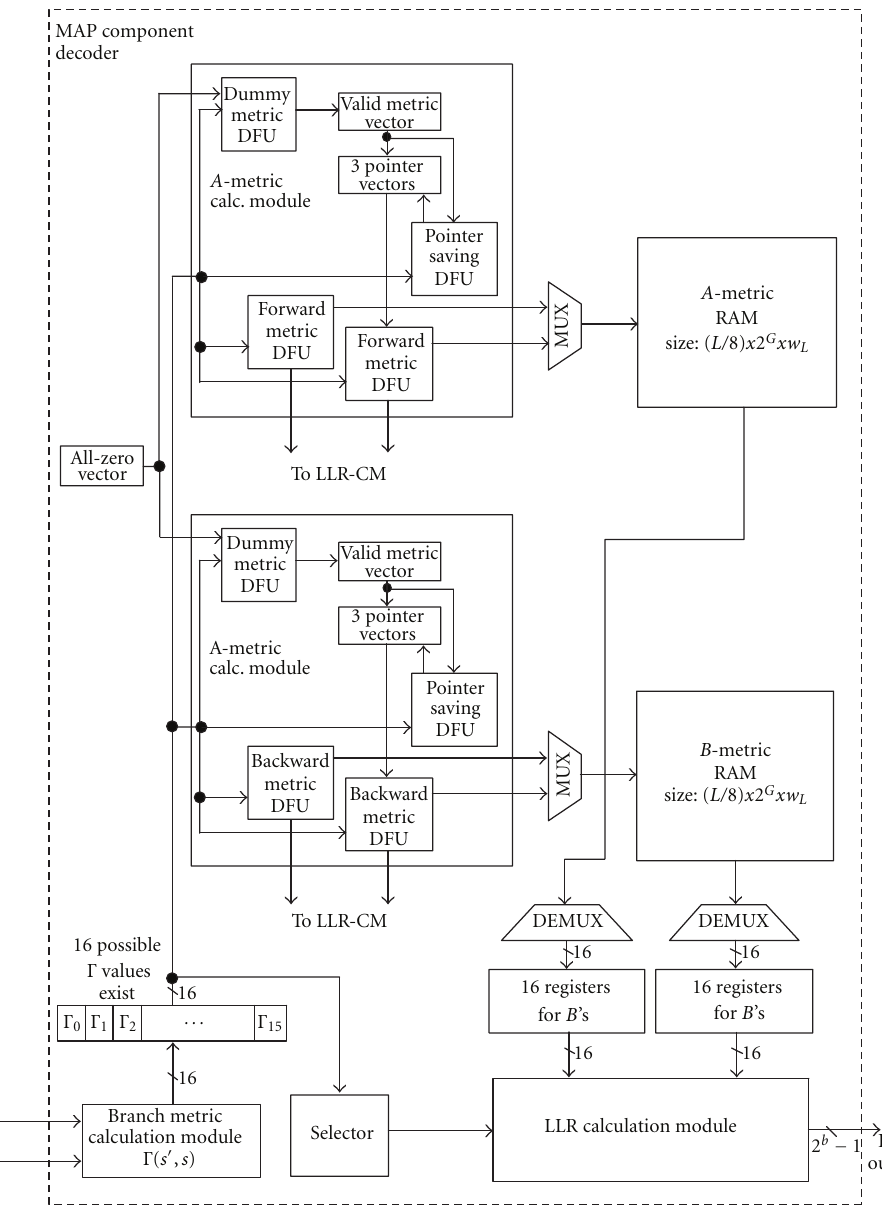
Figure 13: VLSI Architecture for SWT-based MAP decoder using the double-flow structures and the pointer technique.